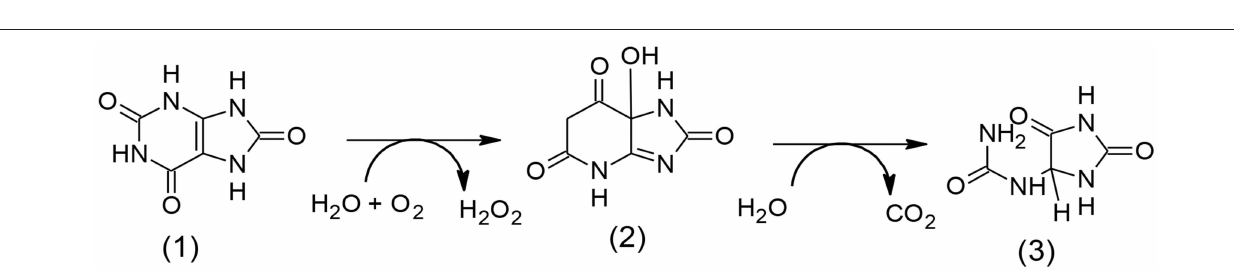
FIGURE 1 | 3D Structures of urate oxidase and human haematopoietic cell kinase. (A) 1WS3. (B) 2HCK.